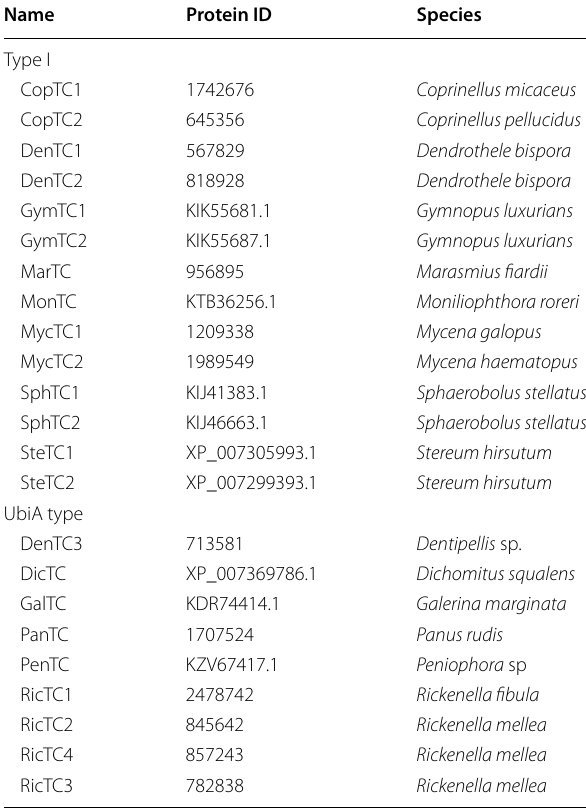
Table 2 Putative diterpene synthases (di-TPSs) from sequenced basidiomycete fungi and experimentally characterized